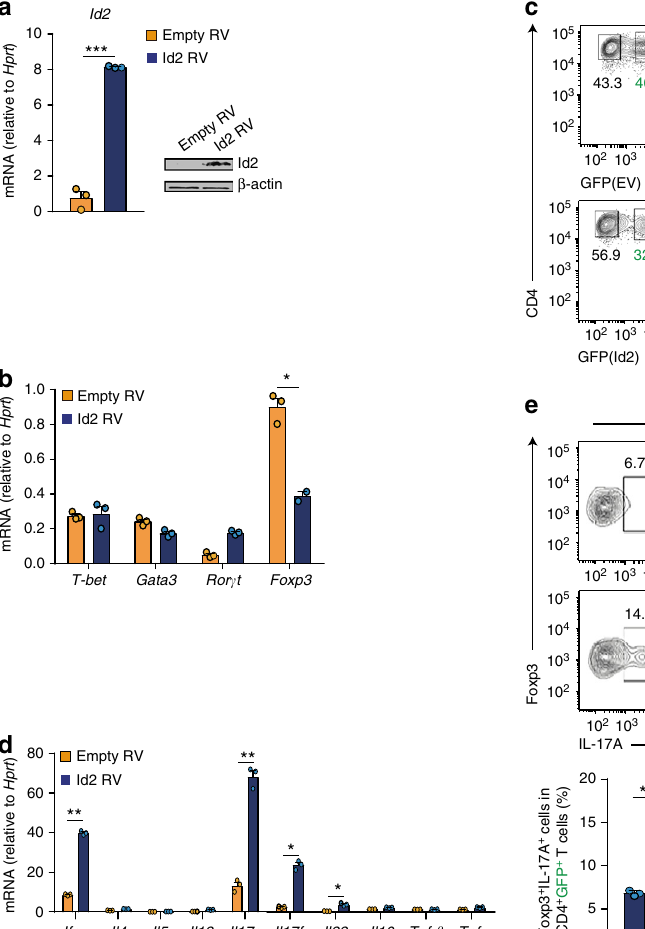
animal model for multiple sclerosis in which T reg cell instability and conversion to effector T cells is well documented 13,25,26 . For this we crossed Id2 EmGFP Foxp3 YFP − Cre mice with mice harboring